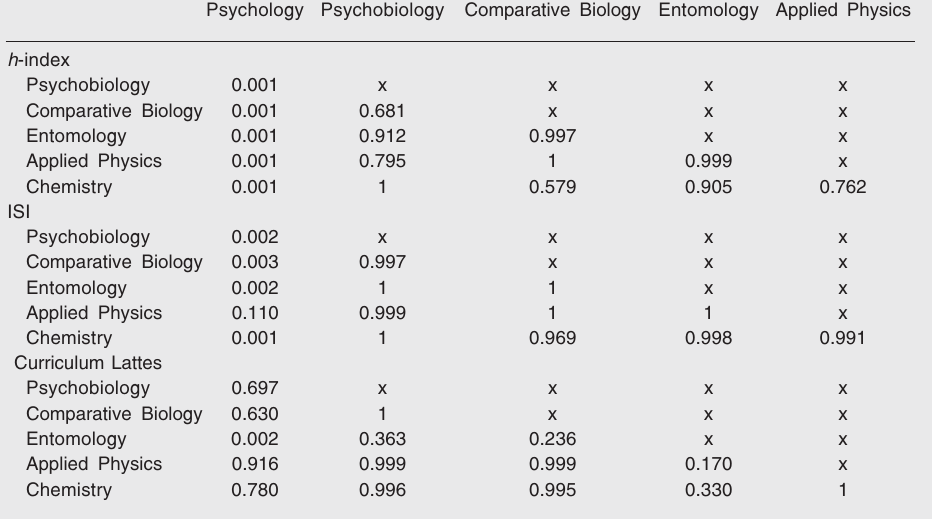
Table 5. P values of the hypothesis test concerning equality between graduate programs of the Faculdade de Filosofia, Ciências e Letras de Ribeirão Preto,